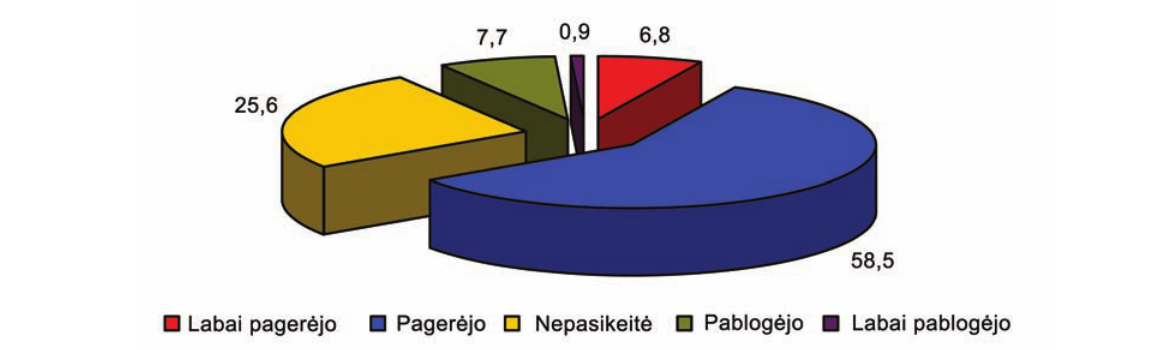
Fig 9. Assessment of changes in Vilnius according to the citizens’ poll results, 2005